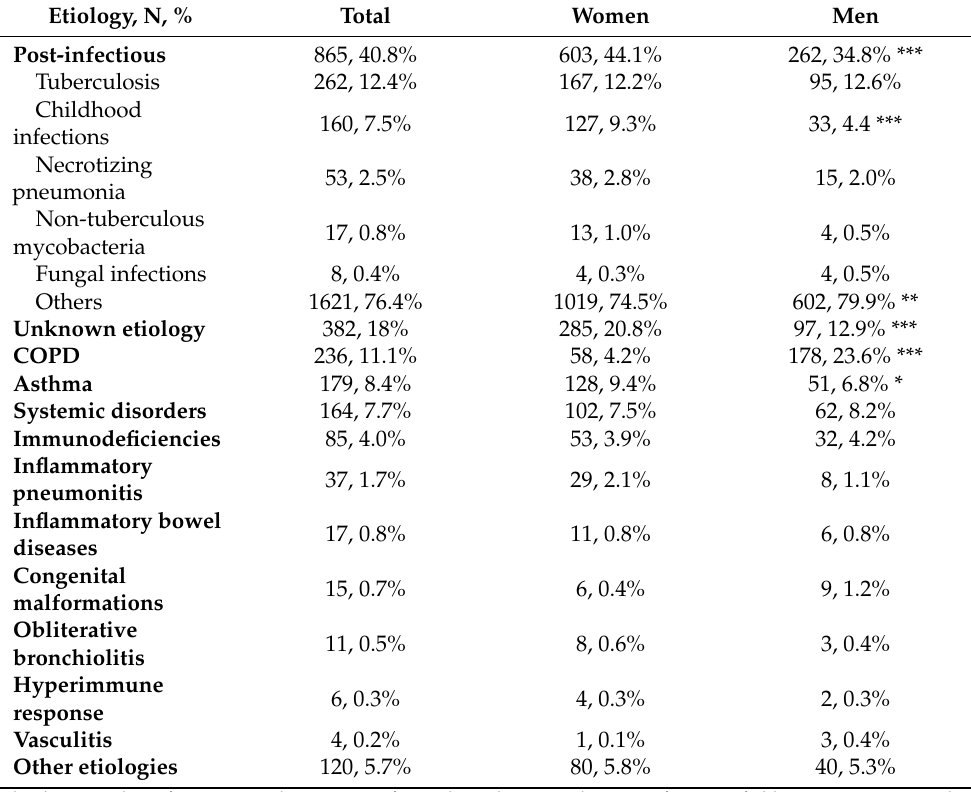
Table 4. Etiology of non-CF bronchiectasis